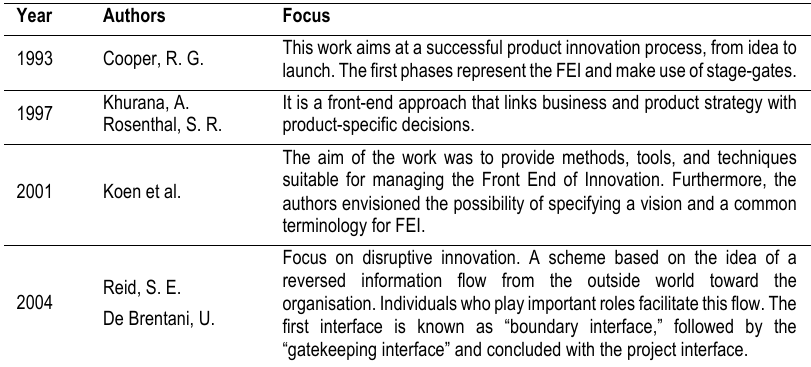
Table 1. FEI Reference